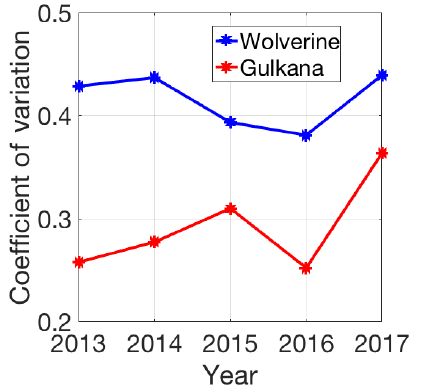
Figure 7. Spatial variability in snow accumulation across the glacier quantified by the coefficient of variation (standard deviation/mean) for each glacier across the 5-year interval based on MVR model output.